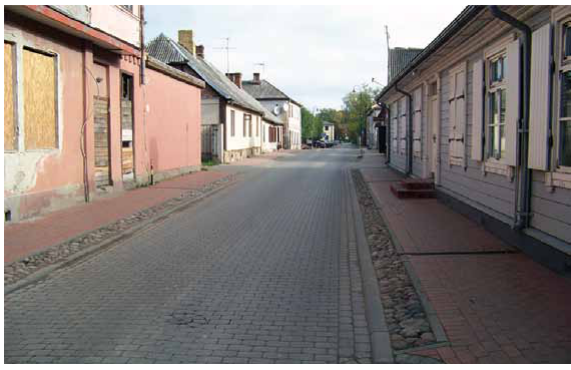
Fig. 1. Perimetral buildings in the Town Hall Square of Bauska along riga street no trees (‘20s of the 20th century). Source: a photo of local History Museum of Bauska.